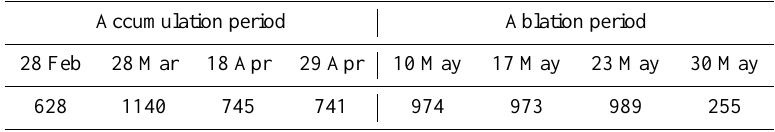
Table 2. Total rBC (ngcm − 2 ) of snow pit profiles shown in Fig. 1. Accumulation